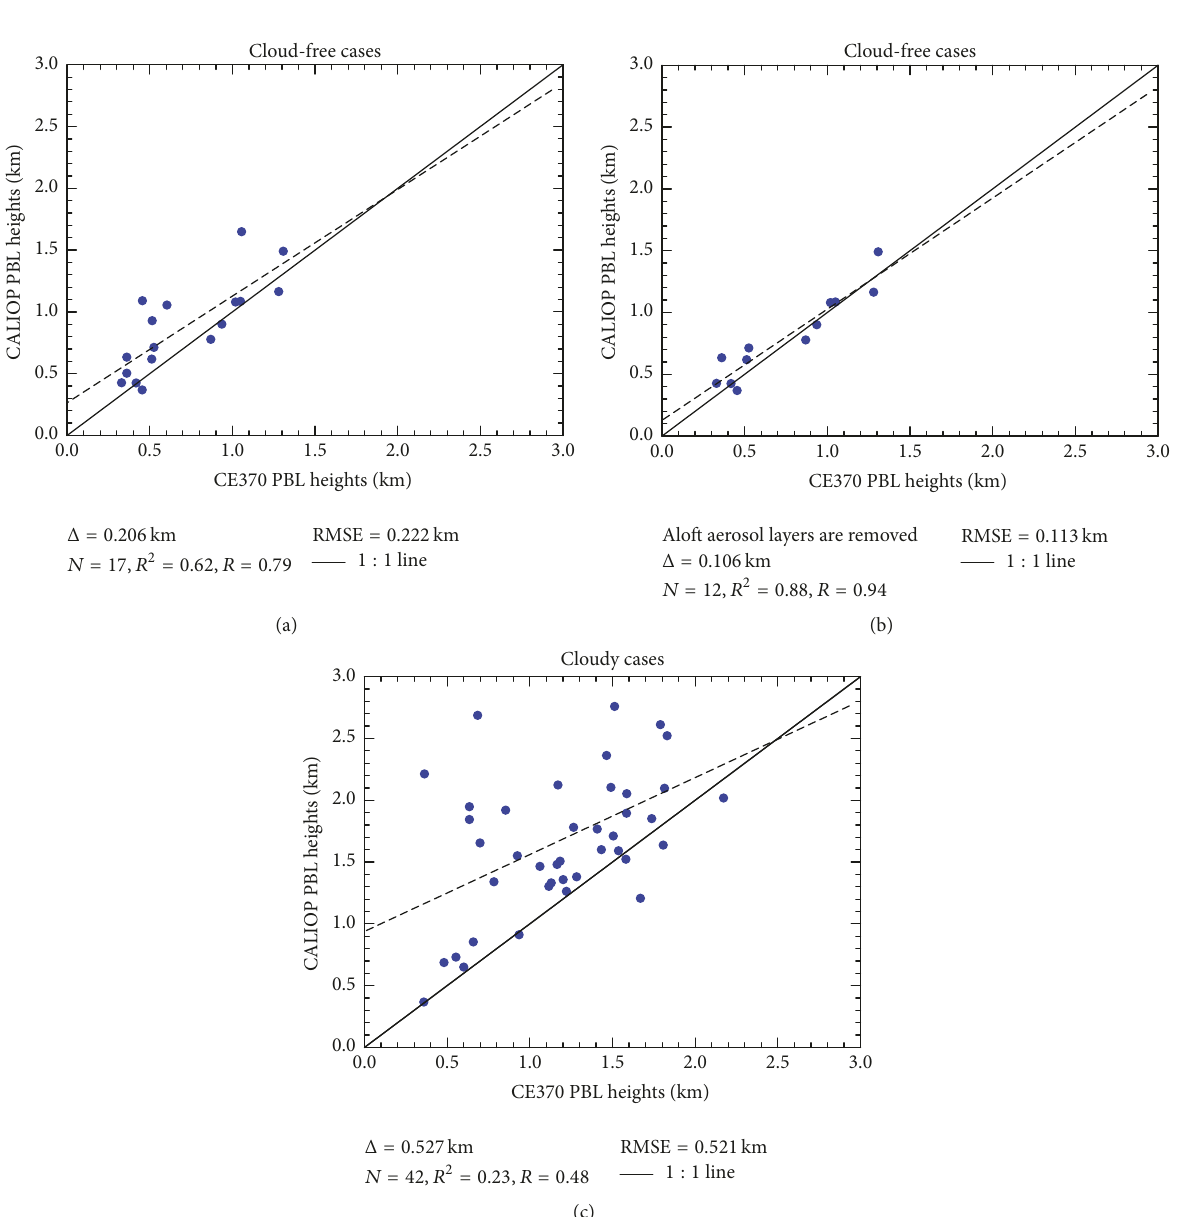
Figure 11: The correlation of PBLHs derived from CE370 and CALIOP. (a) In cloud-free cases. (b) Result with the removal of the effect of the aloft aerosol layers in (a). (c) The result in cloudy